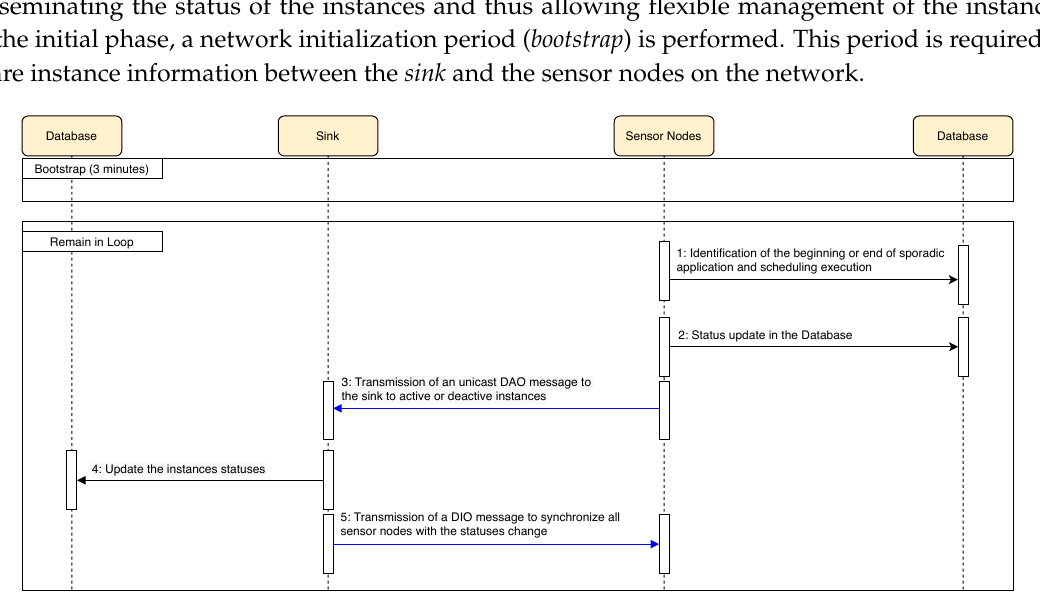
Figure 6. Sequence diagram that shows the interaction between sink, database, and sensor